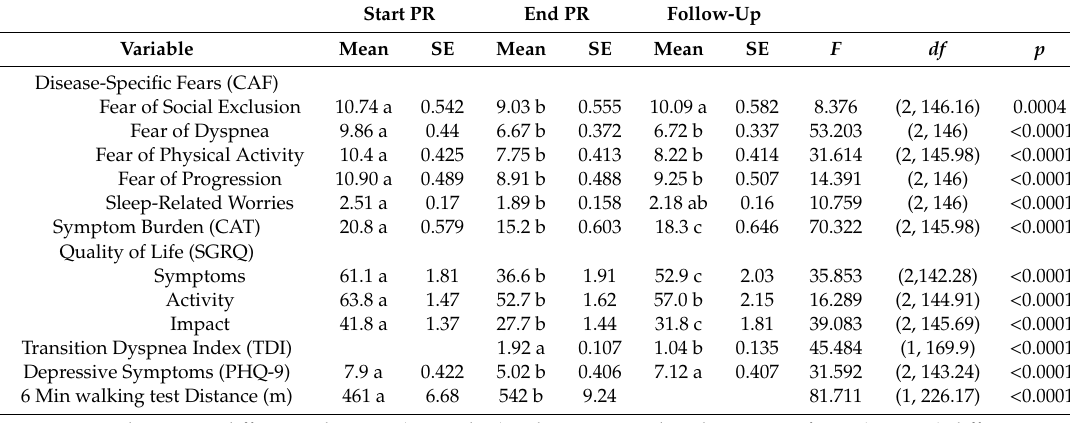
Table 2. Change in disease-specific fears and other pulmonary rehabilitation outcomes. Start PR End PR